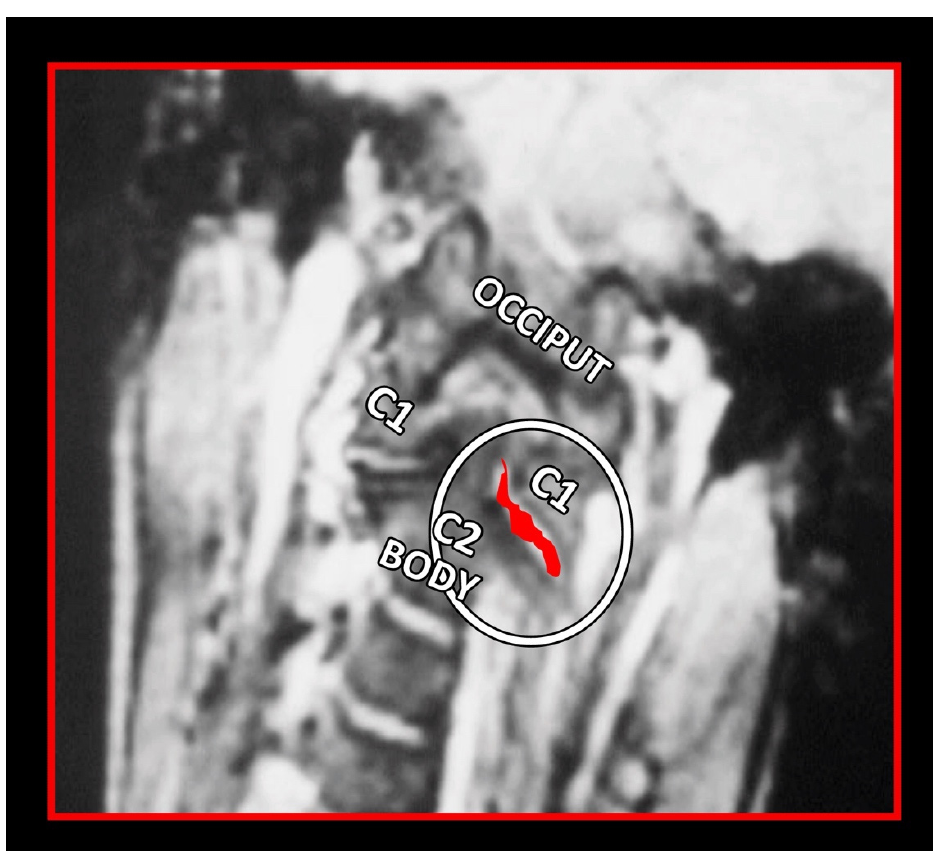
Figure 20. Dynamic coronal magnetic resonance imaging study. Lateral instability of atlas - axis segments. The study facilitates the understanding of the dysfunction to plan the treatment process and restore left rotation of the axis on the C3. Maintain proportional rotational patterns of movement between the atlas and axis .